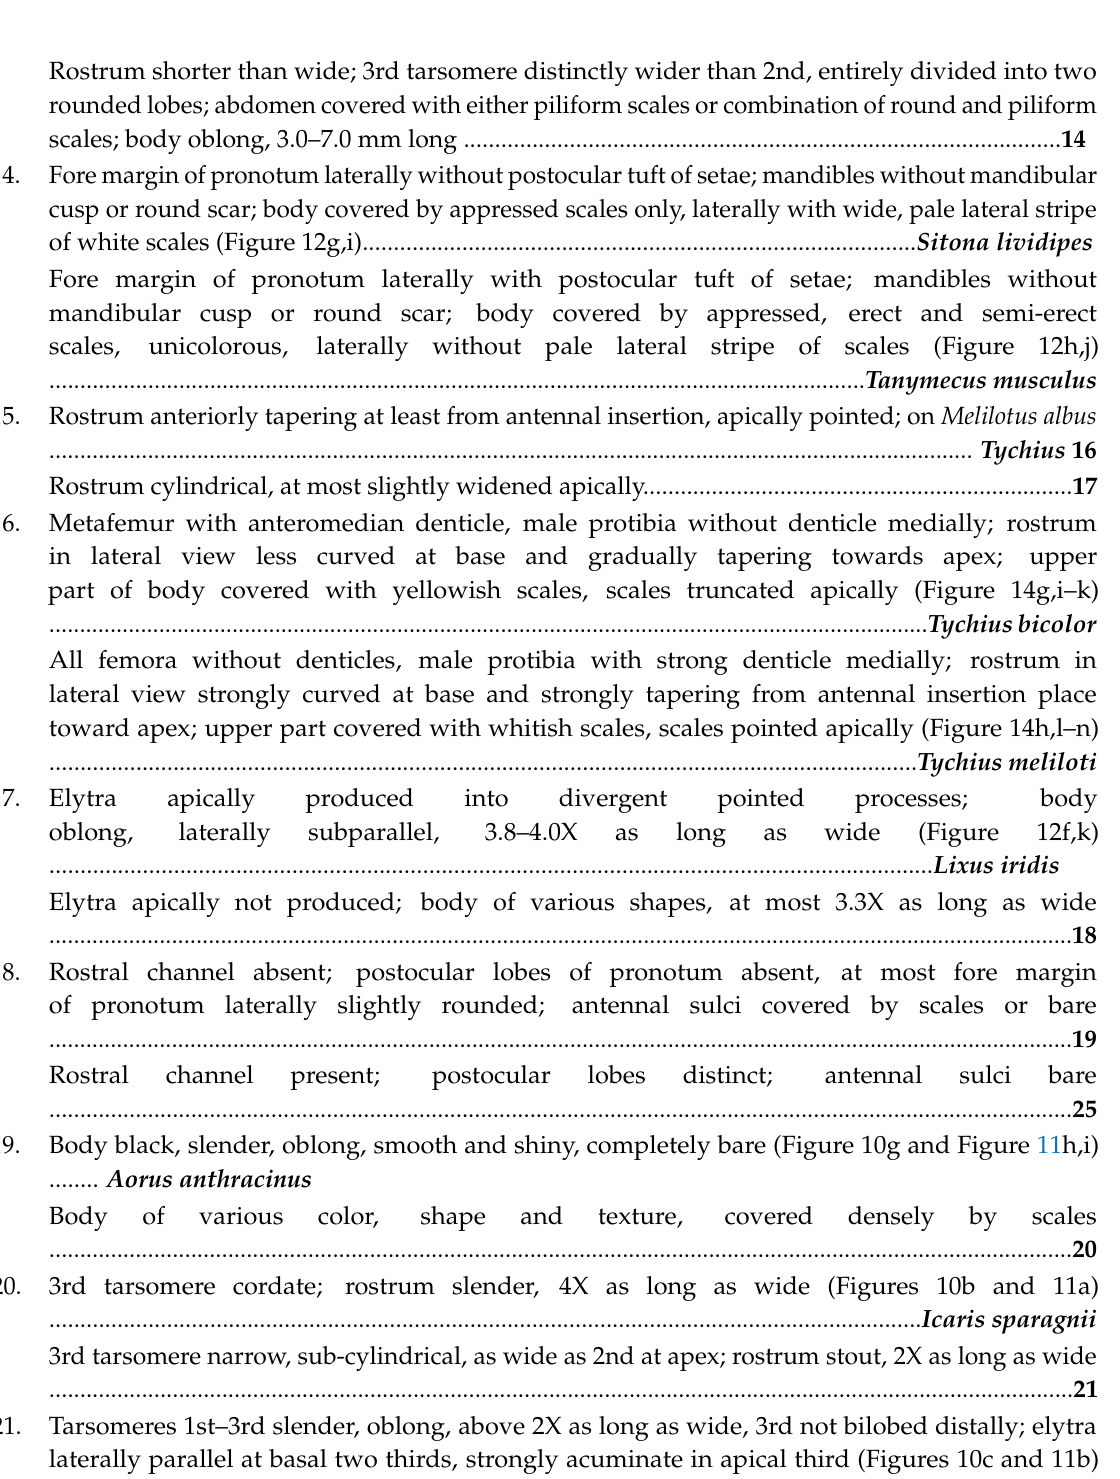
- 21. Tarsomeres 1st–3rd slender, oblong, above 2X as long as wide, 3rd not bilobed distally; elytra